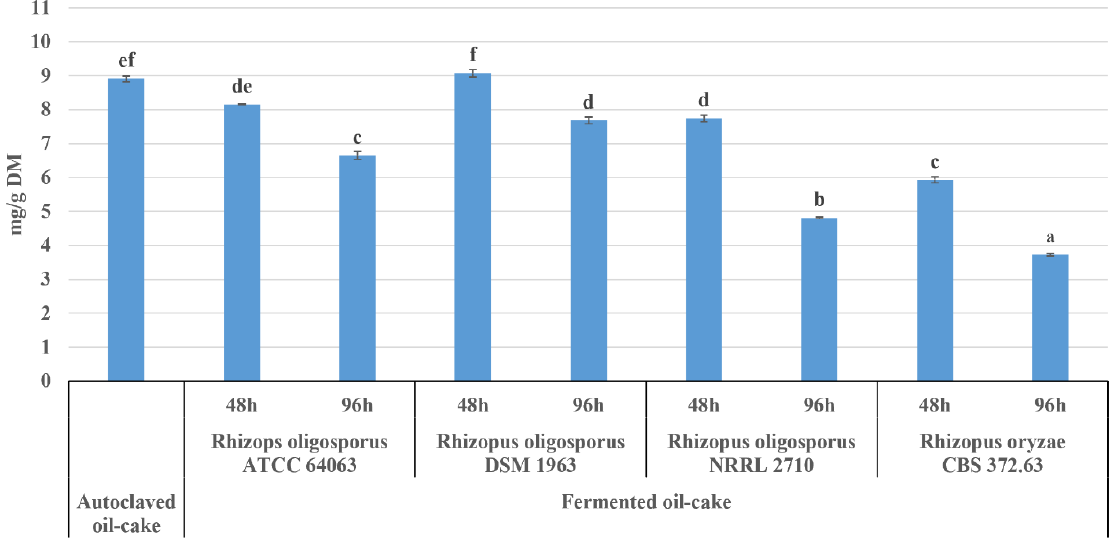
Figure 1. The level of phytate in autoclaved and fermented pumpkin oil-cake. One-way analysis of variance and Tuckey post-hoc test were applied. Data is shown as the mean ± SEM. Different letters depict data that differ significantly ( p ≤ 0.05 ).